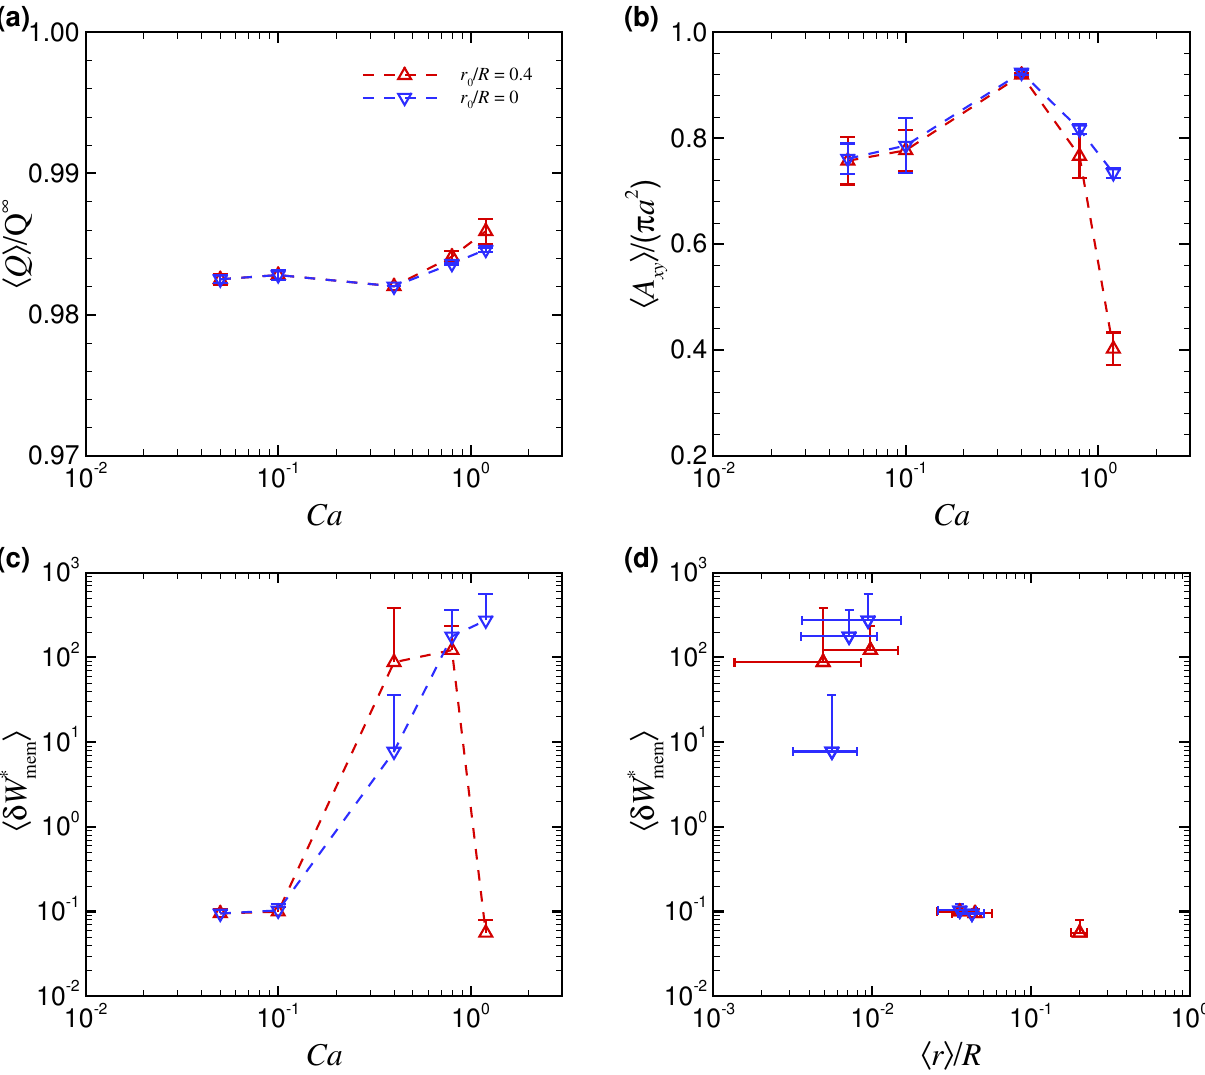
/ Q ∞ , ( b ) projected area of the RBC to the cross-sectional area of Q (cid:104) (cid:105) δ W ∗ mem as a function of Ca (cid:104) (cid:105) δ W ∗ mem as a function of equilibrium radial position (cid:104) (cid:105)